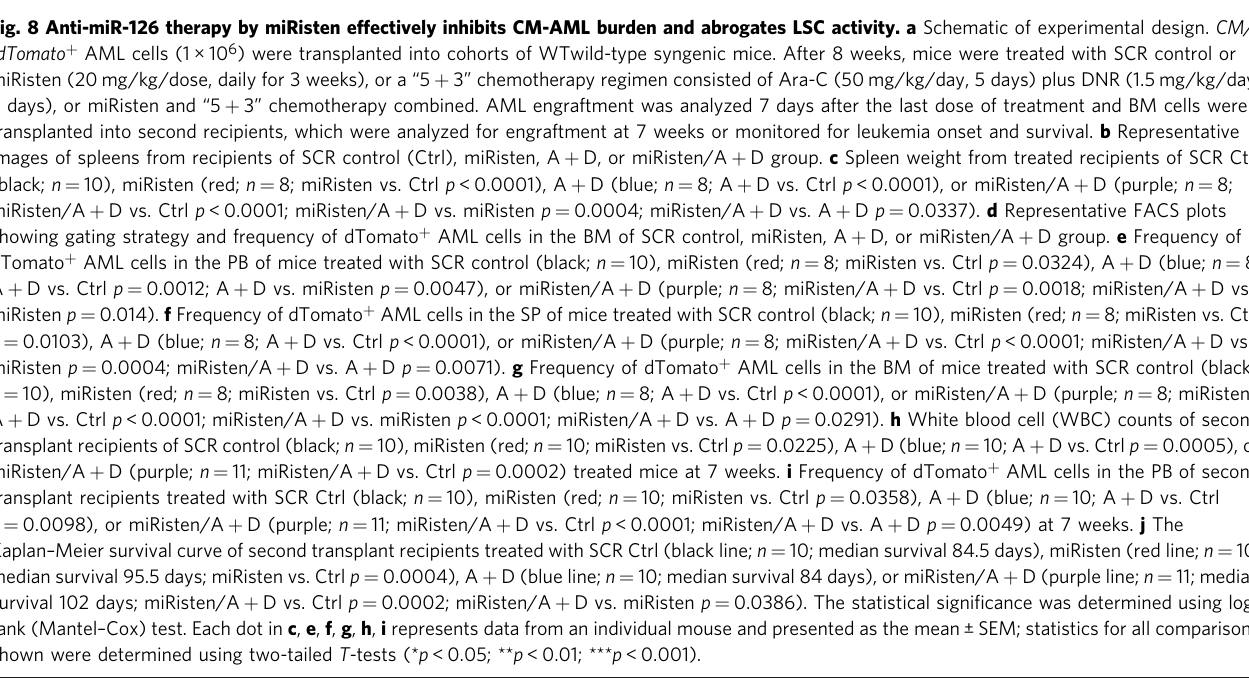
transplant recipients of SCR control (black; n = 10), miRisten (red; n = 10; miRisten vs. Ctrl p = 0.0225), A + D (blue; n = 10; A + D vs. Ctrl p = 0.0005), or transplant recipients treated with SCR Ctrl (black; n = 10), miRisten (red; n = 10; miRisten vs. Ctrl p = 0.0358), A + D (blue; n = 10; A + D vs.